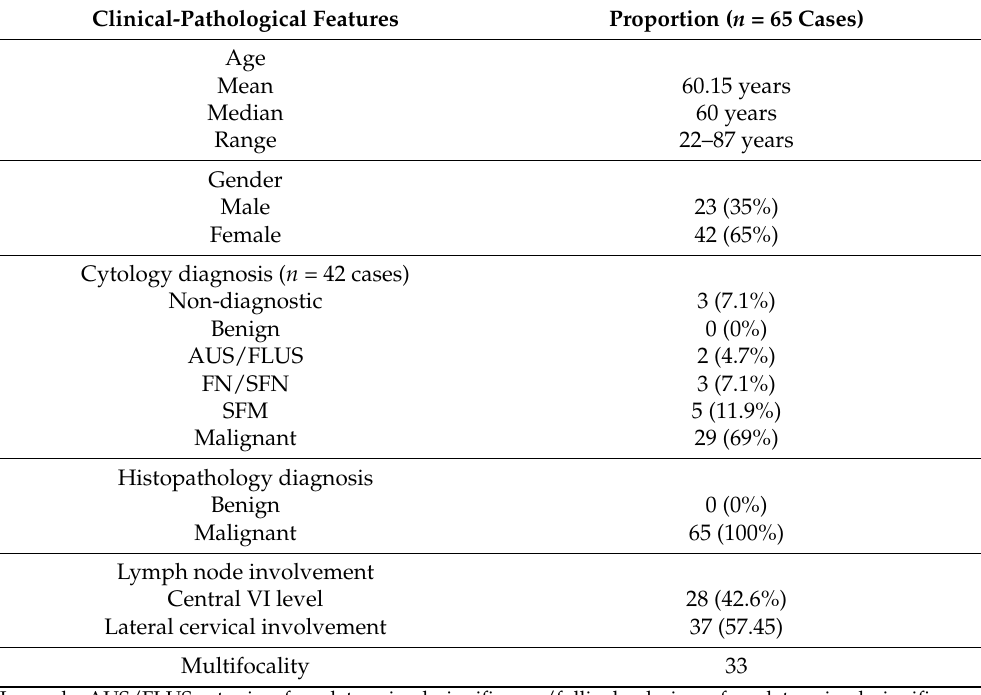
Table 1. Summary of clinical-pathologic data.